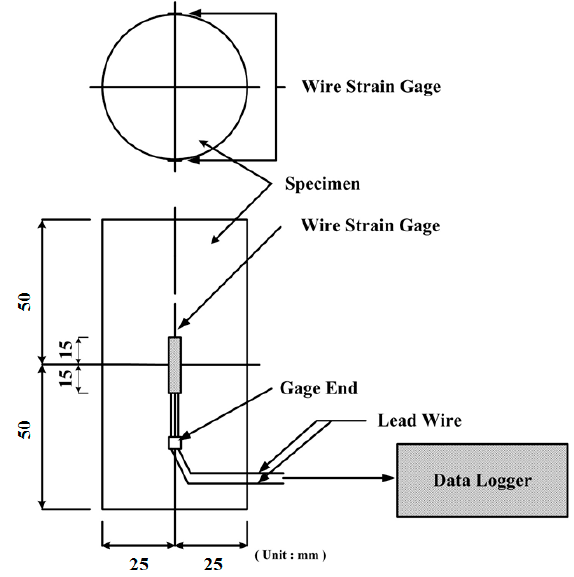
Figure 6. Conceptual drawing of the strain measurement system.